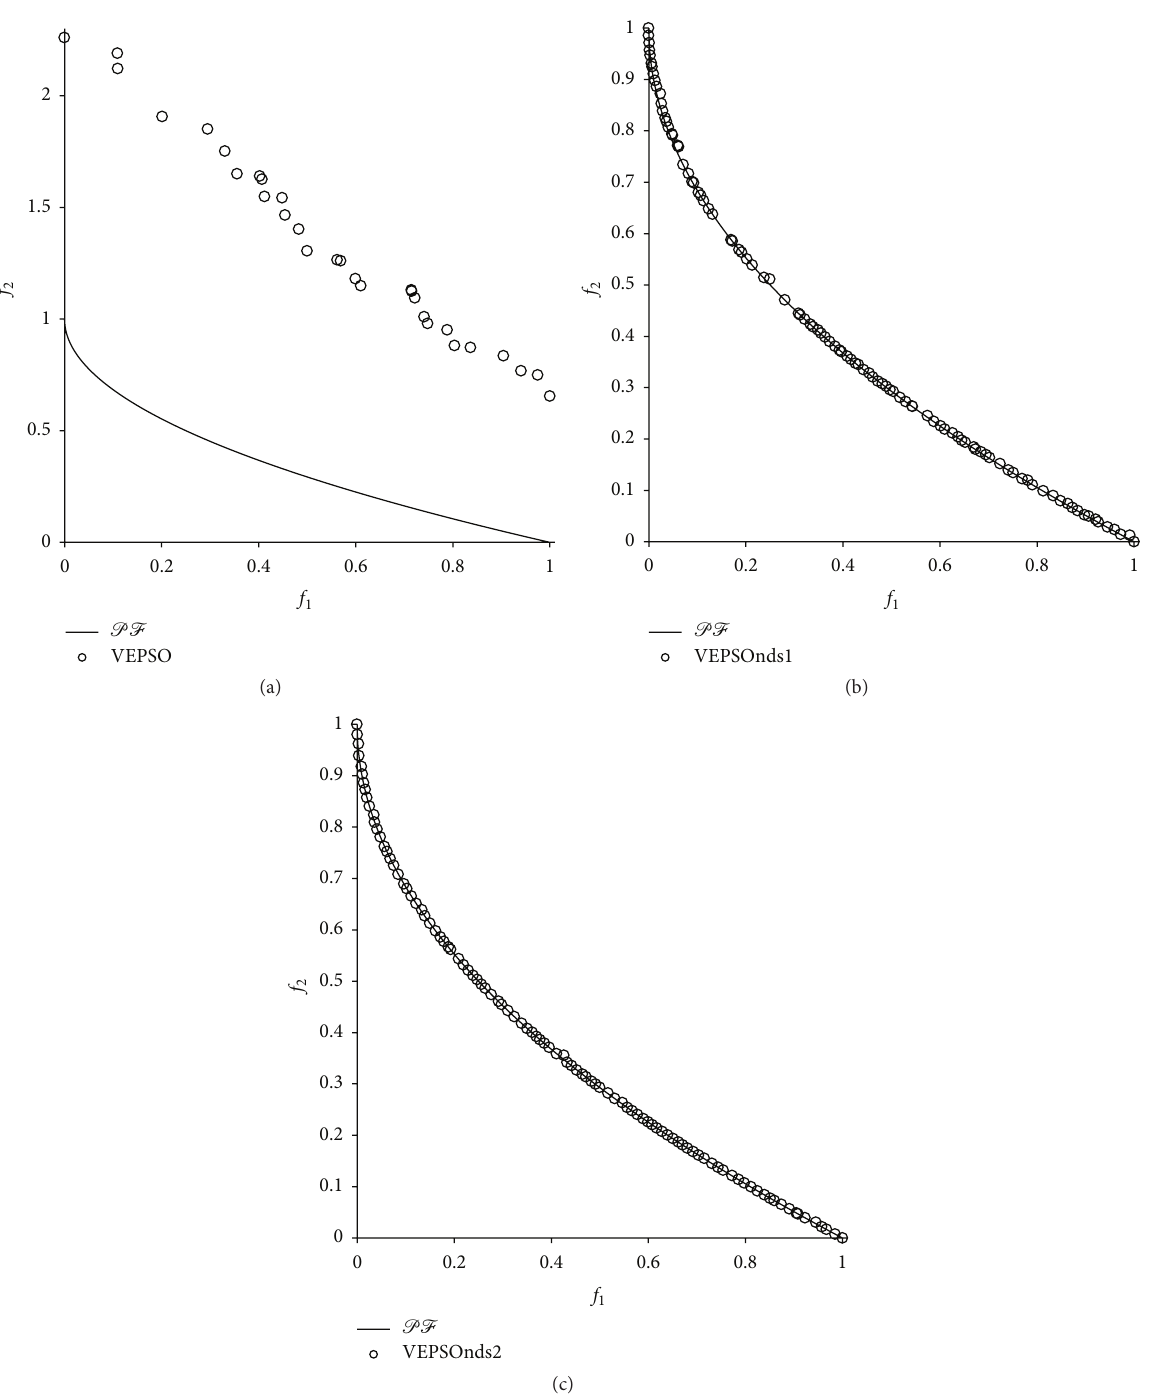
Figure 5: Plot of nondominated solutions returned by each algorithm for the ZDT1 test problem.